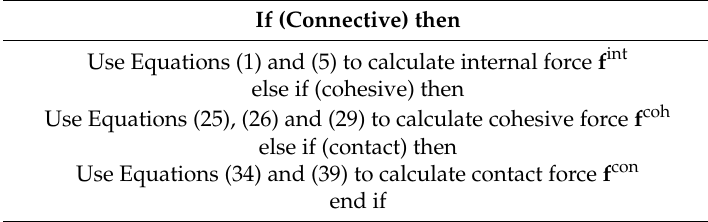
Table 2. Computational procedures of the interaction force between a particle